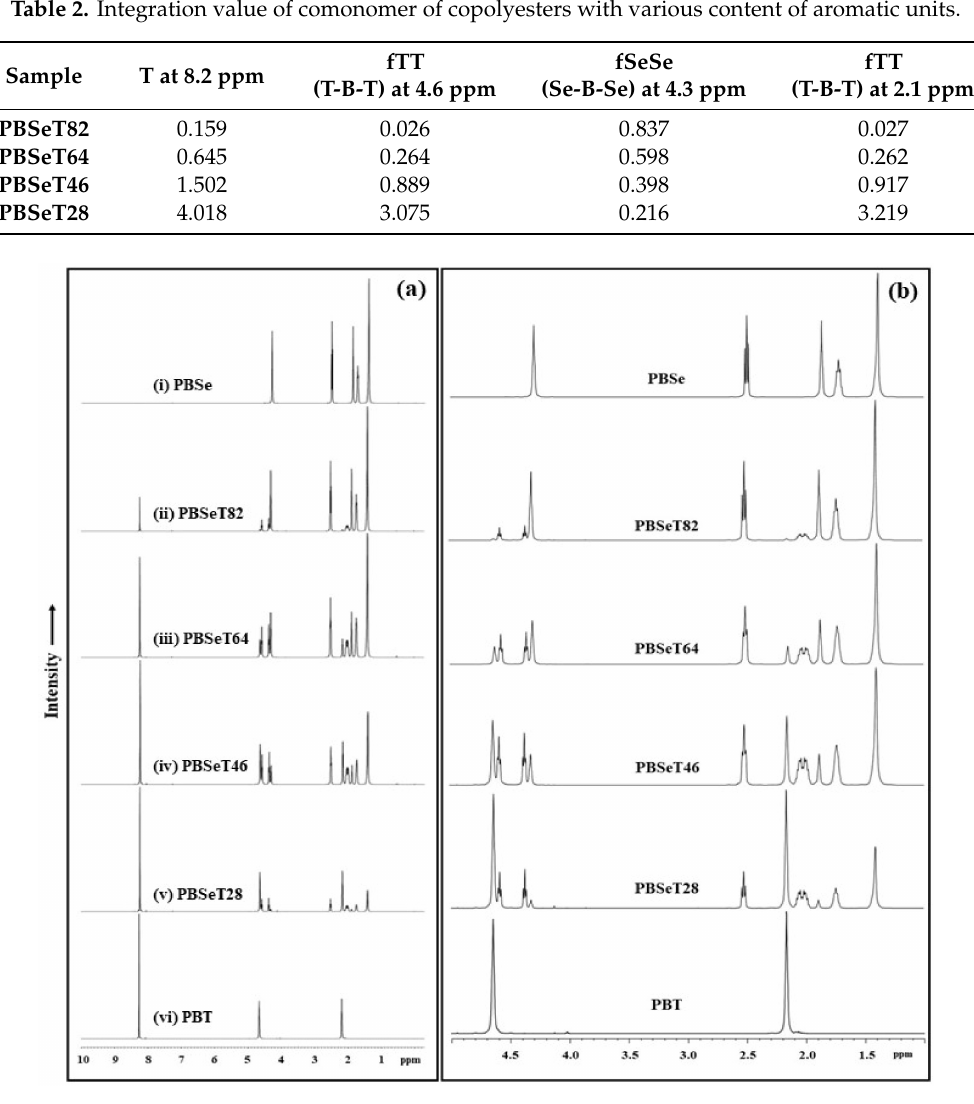
Figure 2. NMR data of the synthesized PBSe, PBT and the PBSeT copolymers with various sebacic acid / dimethyl terephthalate ratios. ( a ) Whole spectra and ( b ) magnification of chemical shift (1.0~5.0